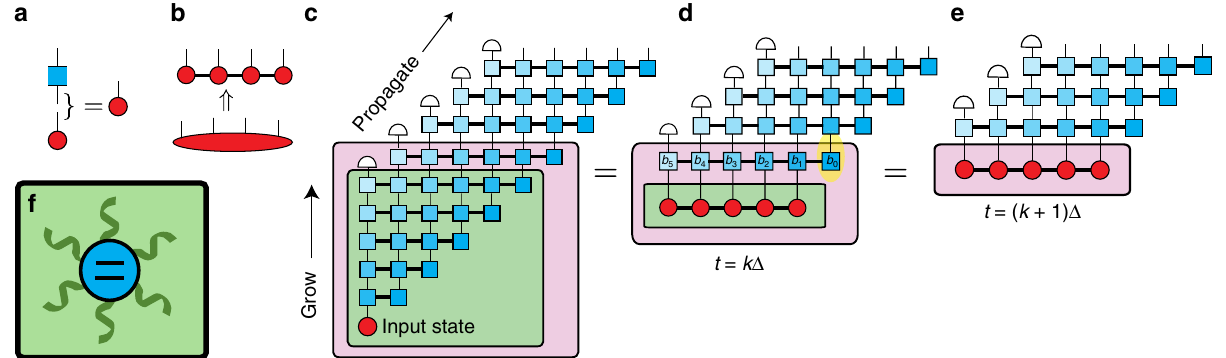
Fig. 1 Schematic description of the TEMPO algorithm. a Pictorial representation of matrix – vector multiplication. In b we show how the ADT can be decomposed into an MPS. c The full tensor network starting from an initial standard density operator which is grown to an ADT with K legs, as shown in d , where we have contracted the contents of the green box. To propagate forward one step, we contract the ADT with the next row of the propagator, as in e . A schematic representation of the spin-boson model is shown in